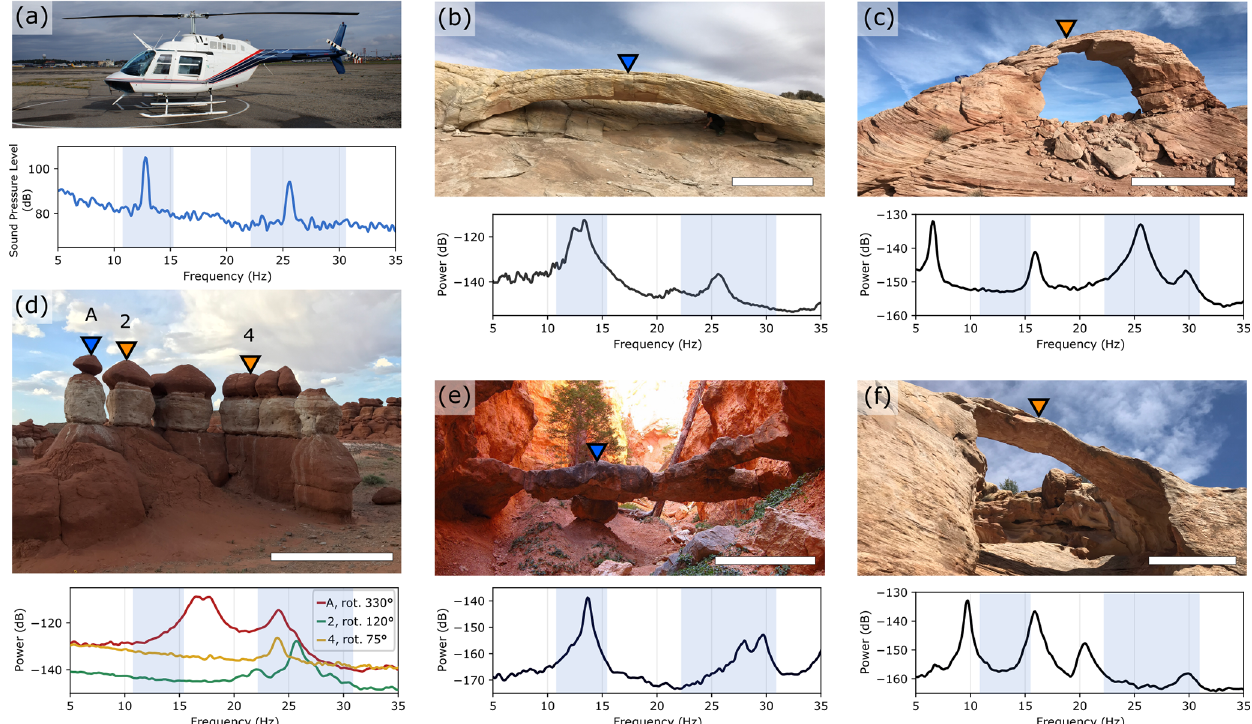
Figure 1. (a) Bell 206 helicopter (credit: Jan Ainali) and stationary infrasound frequency spectrum, with decibel amplitudes relative to 20 × 10 − 6 PaHz − 1 . (b) Squint Arch, (c) Arsenic Arch, (d) Little Egypt, (e) Two Bridge, (f) Big Arrowhead Arch. White bars are approximately 3m. Velocity spectra for the landforms are shown below each photo, with decibel powers relative to 1m 2 s − 2 Hz − 1 . Spectra for arches show the vertical component, while spectra for hoodoos are rotated to the polarization azimuth for the respective mode. The blue-shaded region shows the Doppler-shifted range of helicopter-sourced infrasound (11.1–15.6Hz and 22.2–31.3Hz). Blue triangles indicate locations of broadband seismometers; orange triangles show locations of nodal